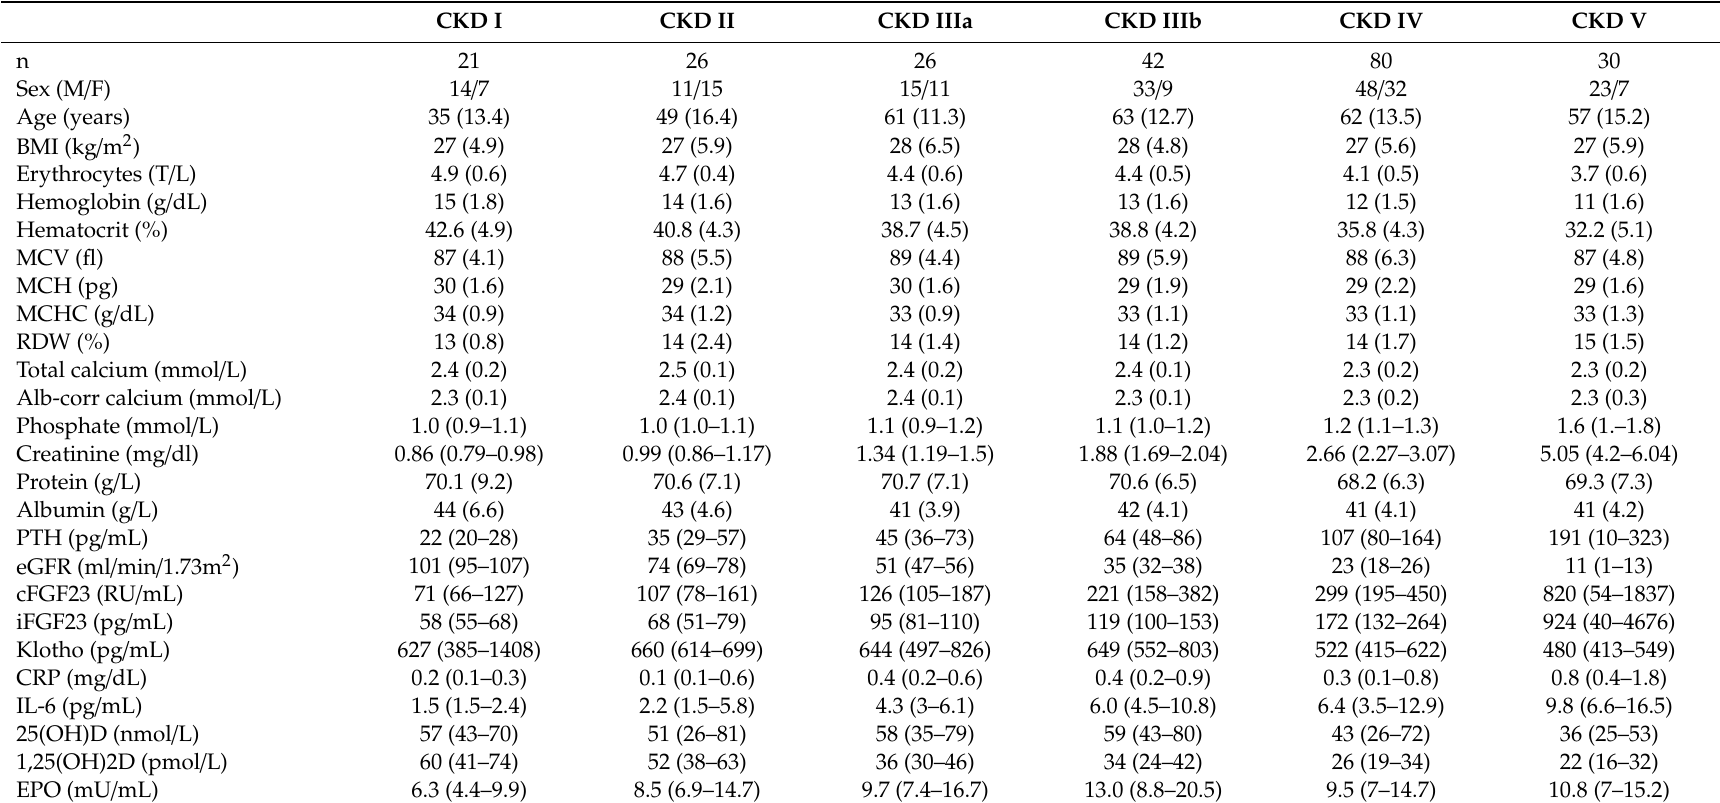
Table 1. Demography and biomarkers of 225 study participants according to the stage of